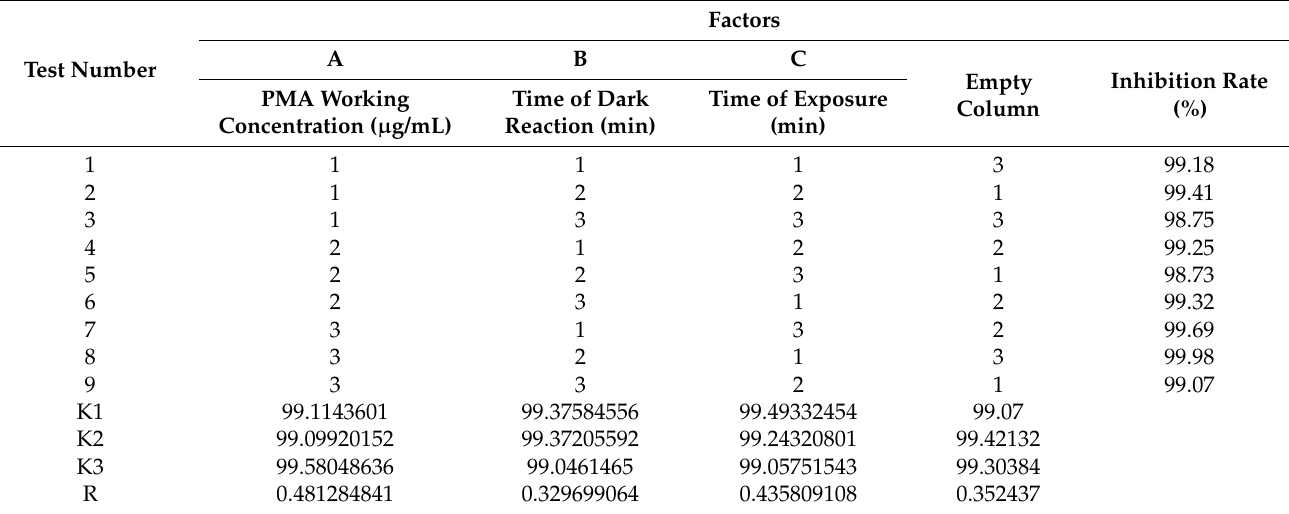
Table 2. Results of L9 (3 4 ) orthogonal experiment.